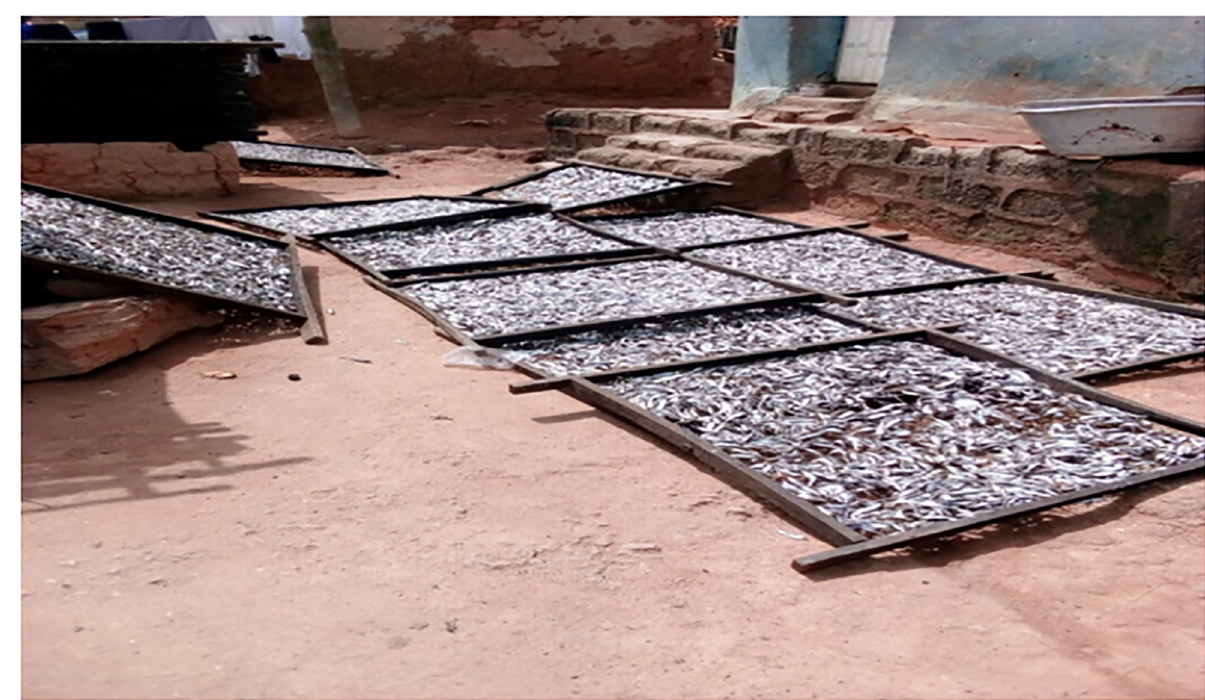
Fig 1. Drying of fish. Washed fish arranged on metal wiring nets with holes and dried under the sun for 20–30 min.